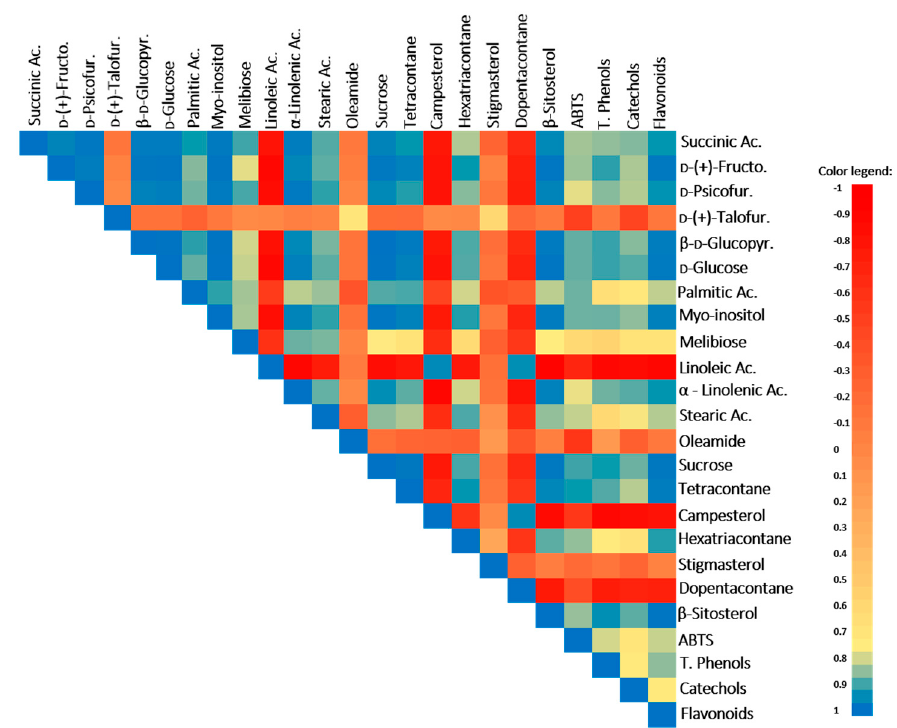
Figure 2. Pearson’s correlation coefficients between parameters in plants of the well-watered (WW) and water deficit (WD) conditions. Coefficients closer to 1 (blue color) mean a positive correlation, 0 (salmon color) indicates no correlation, and − 1 (red color) means a negative correlation. Ac., acid; D -(+)-Fructo., D -(+)-Fructofuranose; D -(+)-Talofur., D -(+)-Talofuranose; D -Psicofur., D -Psicofuranose; β - D -Glucopyr., β - D -Glucopyranose; and LC, long chain .